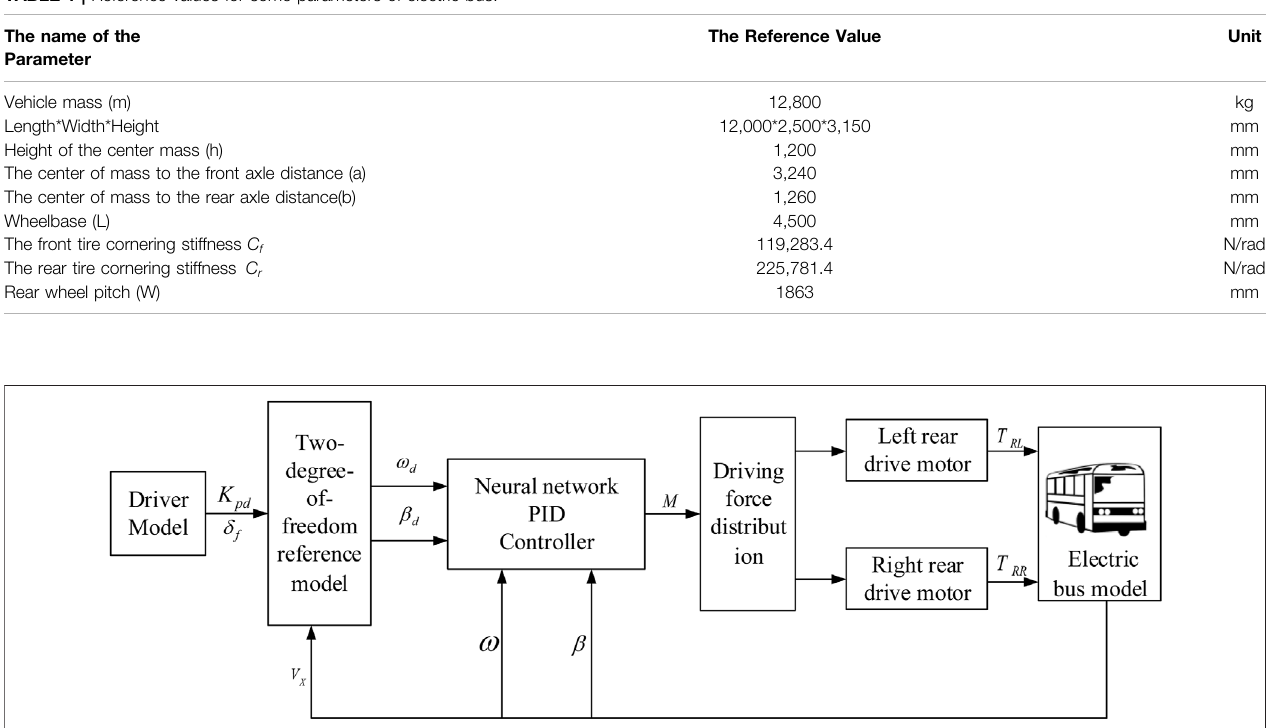
TABLE 1 | Reference values for some parameters of electric bus.